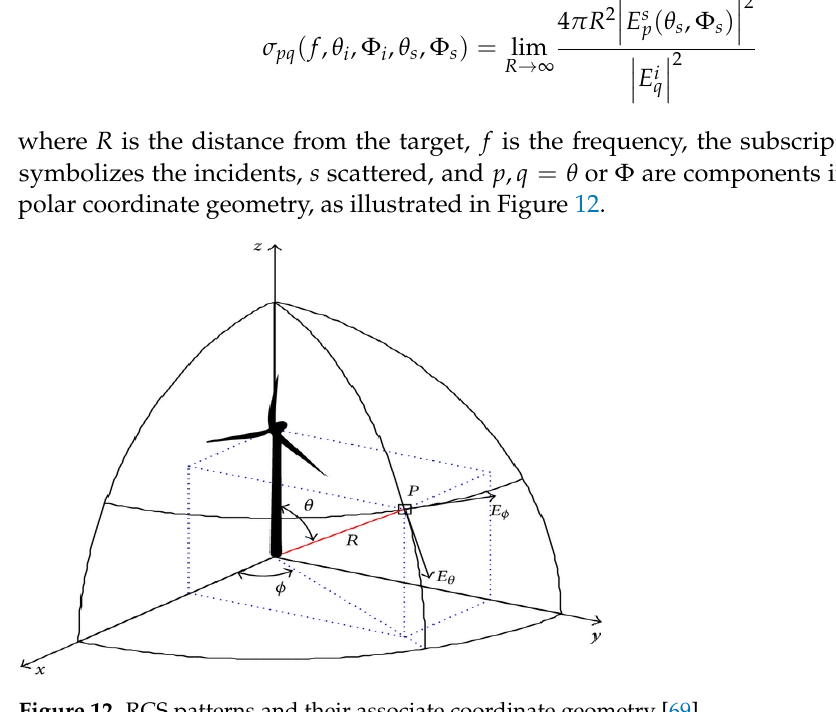
Figure 12. RCS patterns and their associate coordinate geometry [69].